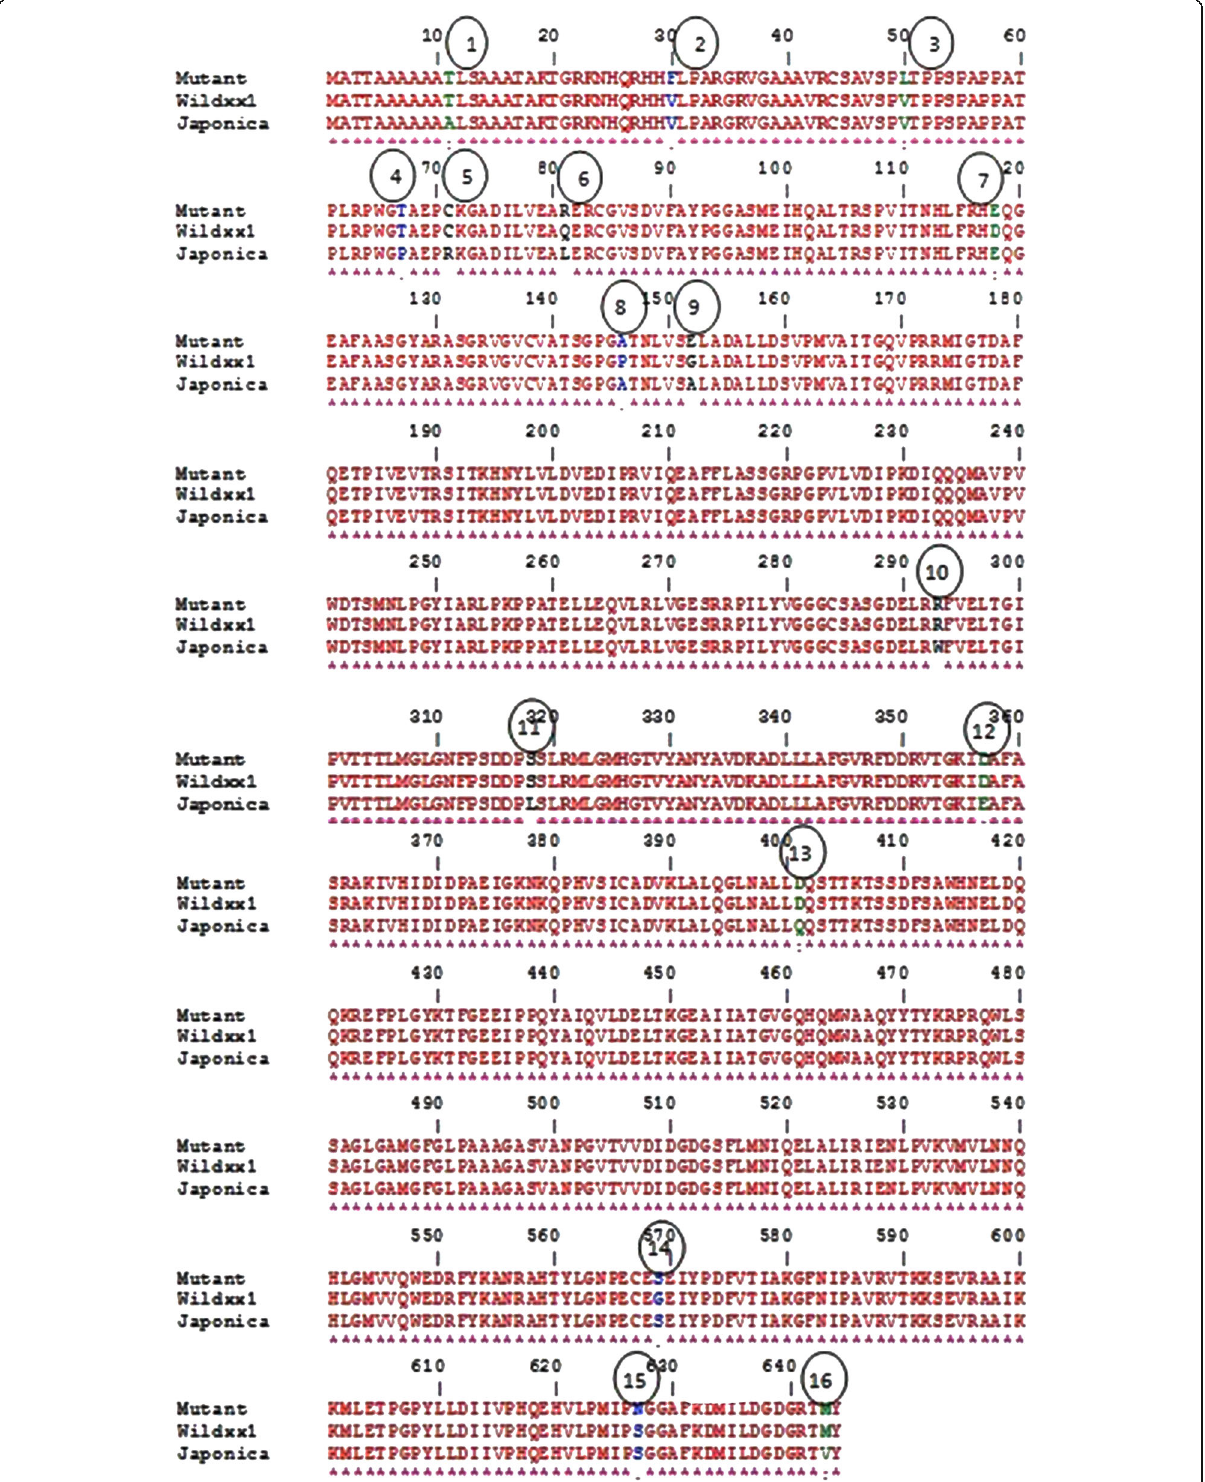
Fig. 5 Amino acid sequence alignment of AcetoHydroxy Acid Synthase (LOC_Os02g30630) between wild type Nagina 22 and herbicide tolerant mutant along with